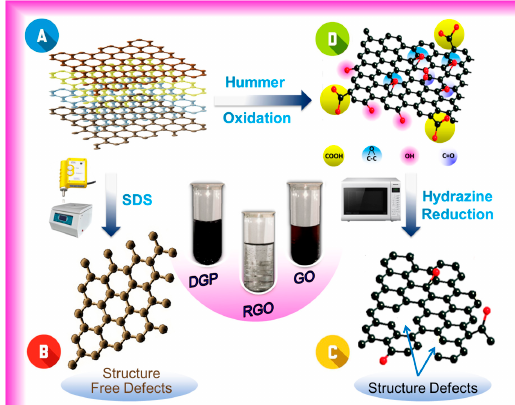
Scheme 1. Graphical representation of graphene synthesis prepared from the Hummer method and dispersion technique using sodium dodecylbenzenesulfonate (SDS): ( A ) graphite structure; ( B ) dispersed graphene nanoplatelets; ( C ) reduced graphene oxide; and ( D ) graphene